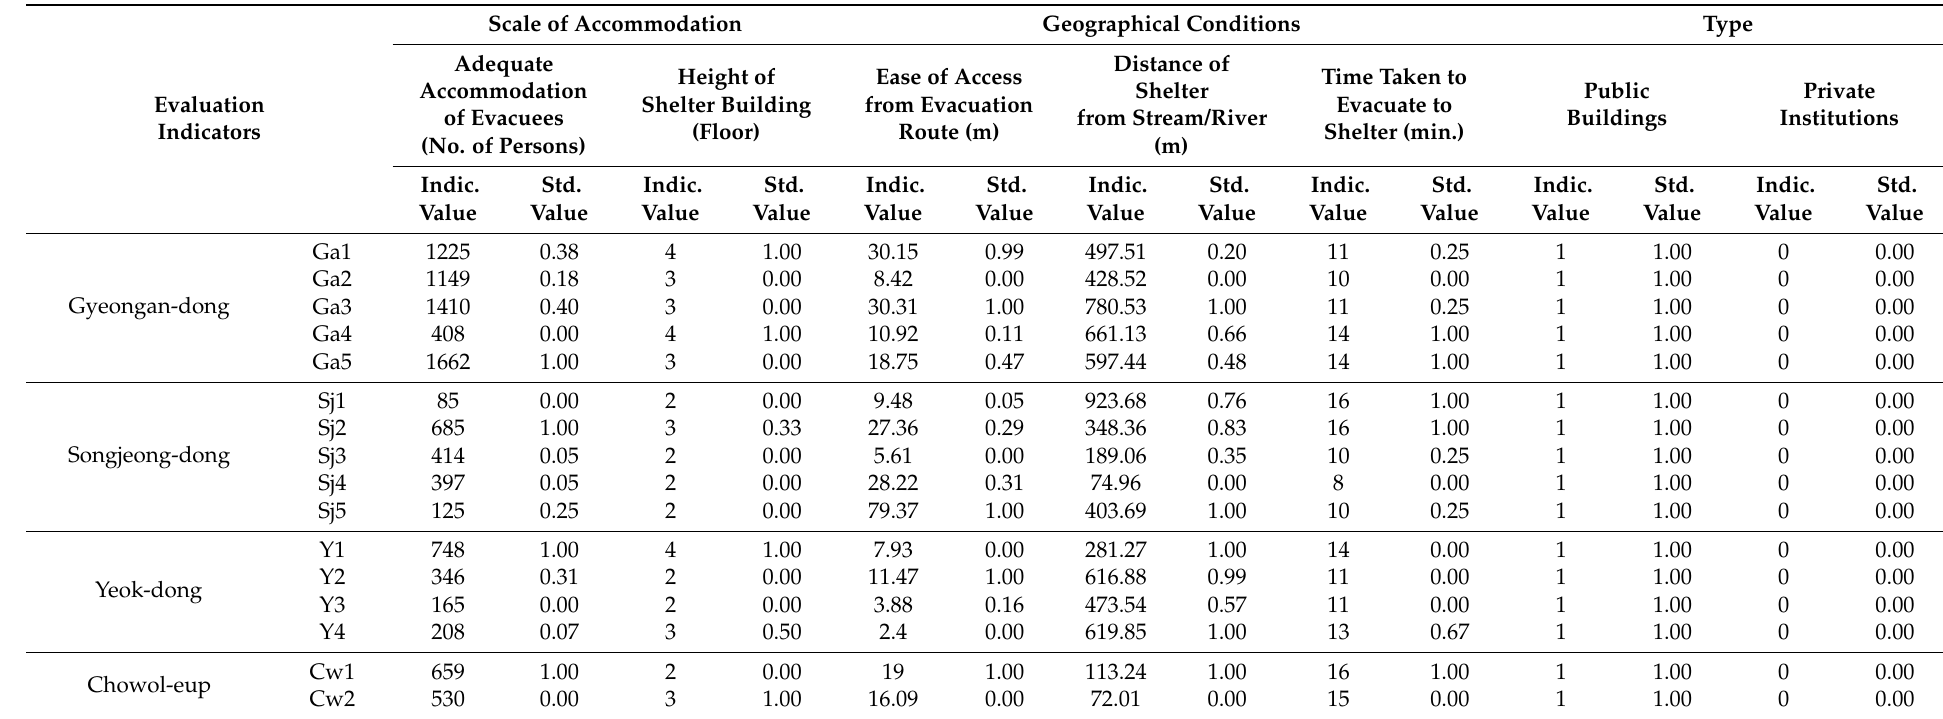
Table 5. Data collection and standardization of shelter evaluation